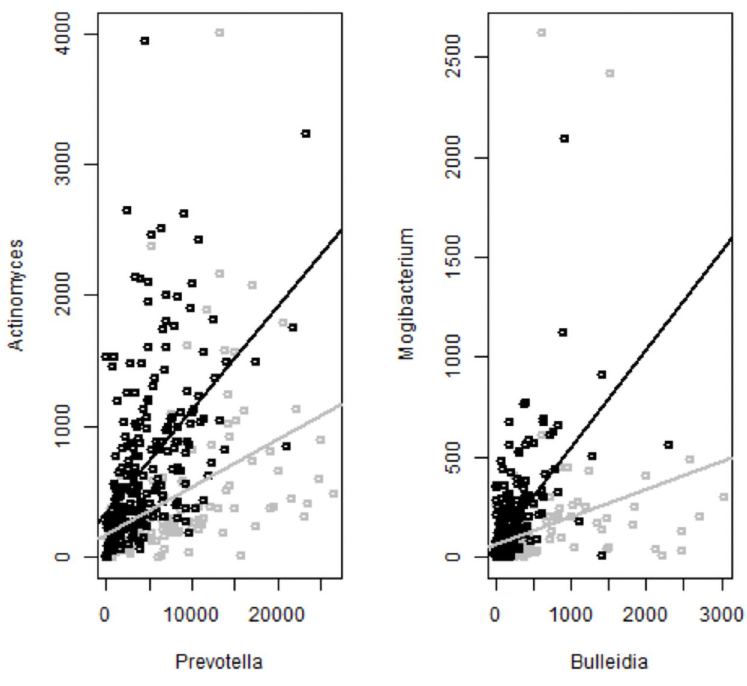
Fig 1. Two pairs of bacteria with a differential relationship between oral cancer cases (red) and healthy controls (black). Black and red lines represent linear regression lines fitted within cases and controls separately.